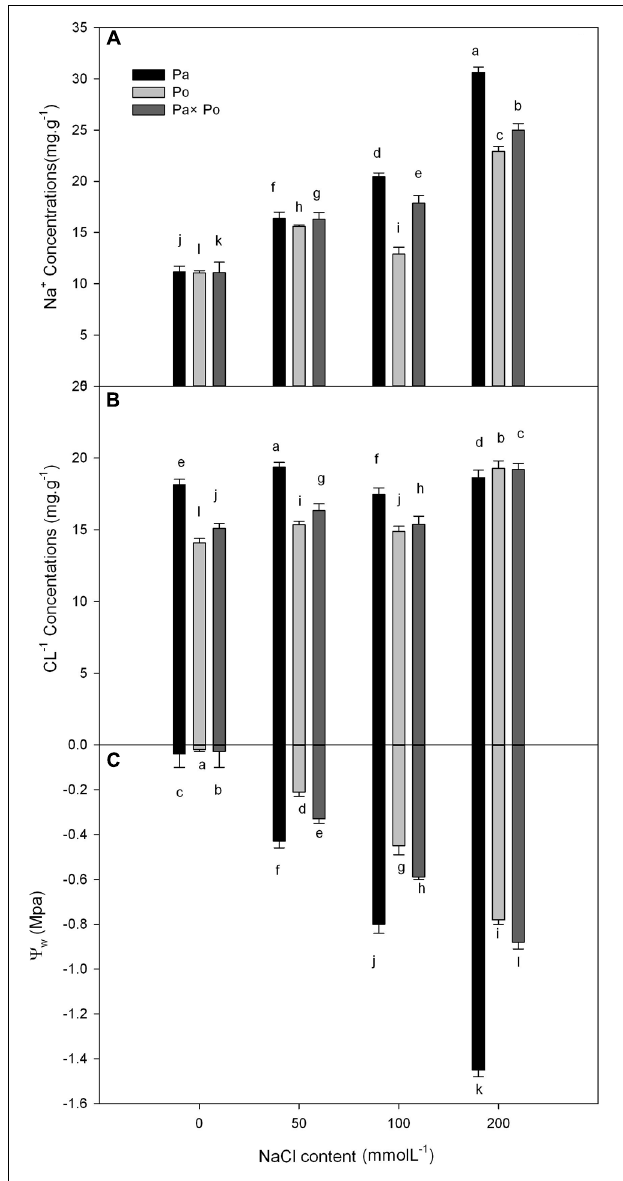
FIGURE 10 | The effect of salt stress on the leaf water potential, and leaf Na + and Cl − concentrations of leaves from three P. amurensis sample groups. Na + concentrations of leaves from three P. amurensis sample groups (A) . Cl − concentrations of leaves from three P. amurensis sample groups (B) . Water potential of leaves from three P. amurensis sample groups (C) . Note: Pa, P. amurensis Maxim (